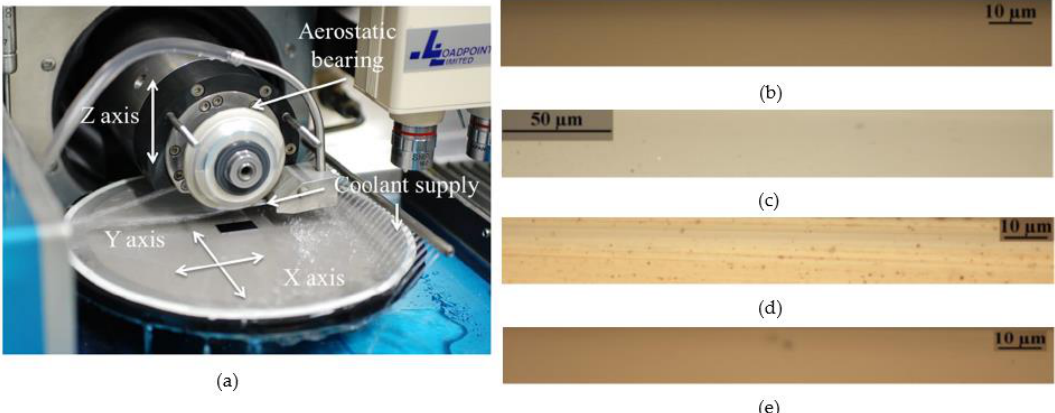
Figure 18 . ( a ) A dicing machine (Loadpoint, MicroAce, Series 3) with the axes of movement and the coolant supply; microscopic image for ductile machining of ( b ) germanium; ( c ) YAG; ( d ) lithium niobate; ( e ) silicon [74].